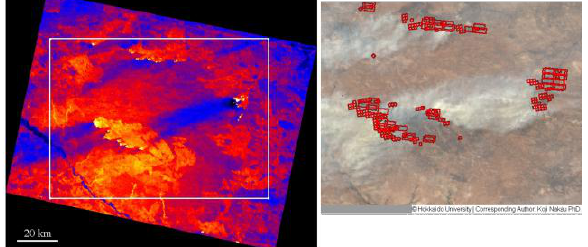
Figure 13. Detected wildfire in Angola (left panel) on August 31 at UTC 10:29. Right panel shows MODIS visible image. Red areas are wildfire detected (MOD14) provided by Nakau.